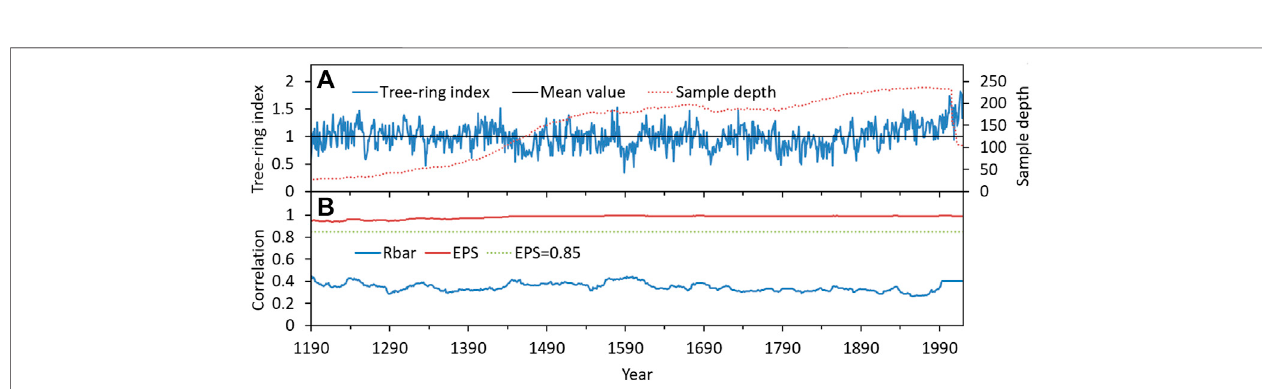
Frontiers in Earth Science |